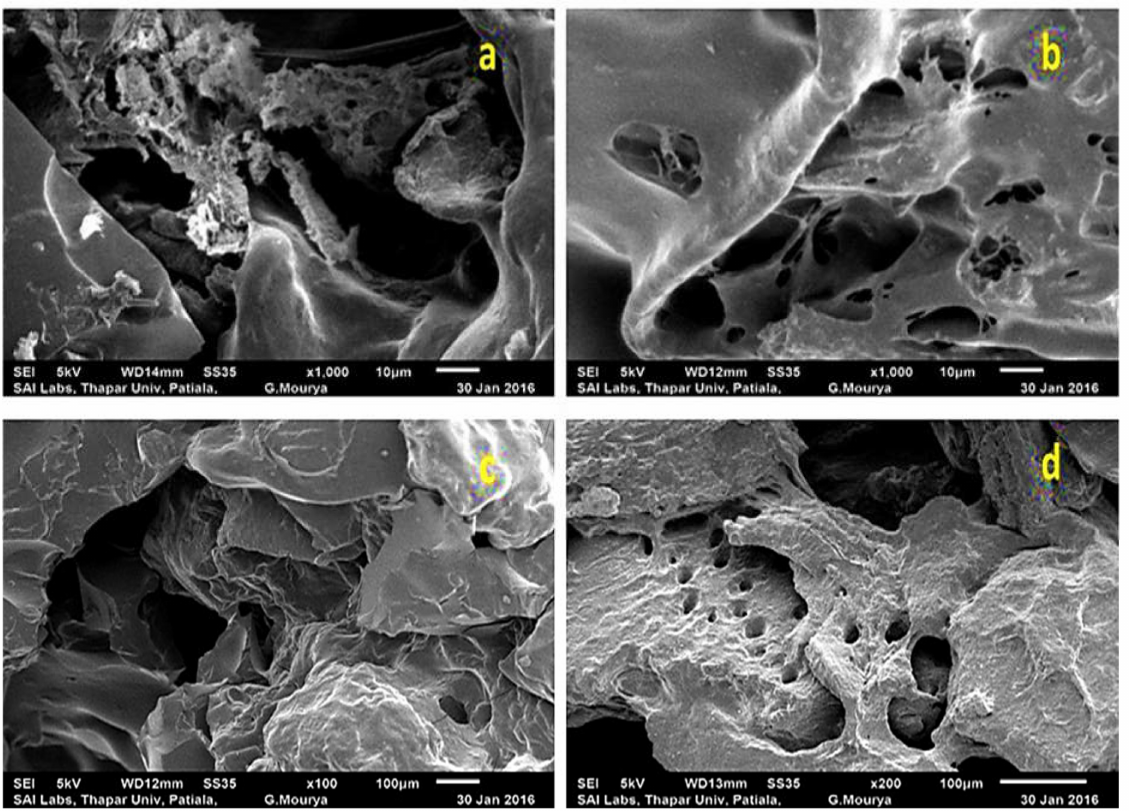
Figure 4. Comparative SEM analysis of chitosan backbone, graft copolymerized samples and crosslinked samples ( a ) Crosslink-Chit- g -polymer (NIPAAM) ( b ) Crosslink-Chit- g -polymer (NIPAAM- co -AA) ( c ) Crosslink-Chit- g -polymer (NIPAAM- co -AAm) ( d ) Crosslink-Chit- g -polymer (NIPAAM- co